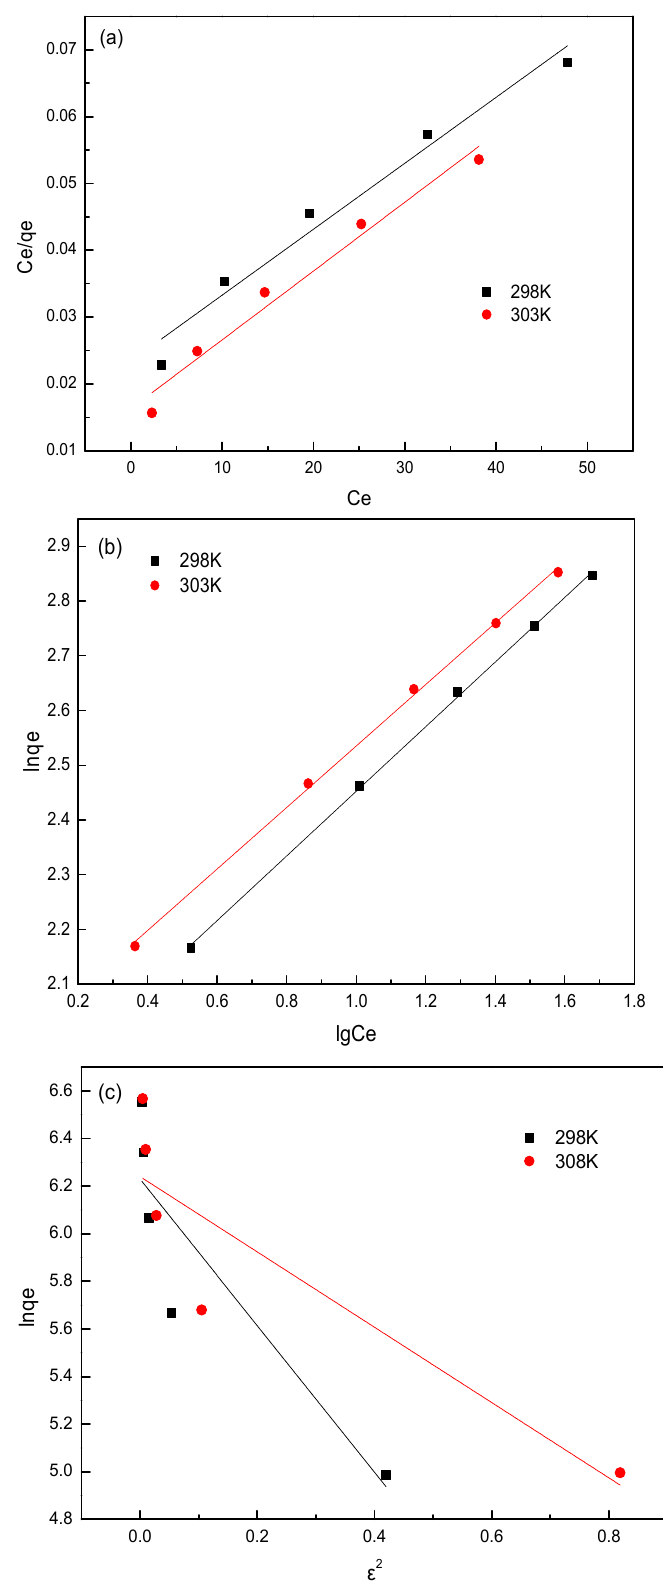
Figure 7. Adsorption isothermal models for adsorption of SL by 2.8%CB-LDH: ( a ) Langmuir model, ( b ) Freundlich model, and ( c ) Dubinin–Radushkevich (D–R) model. Table 3. Isothermal model parameters of SL adsorption by 2.8%CB-LDH. Models